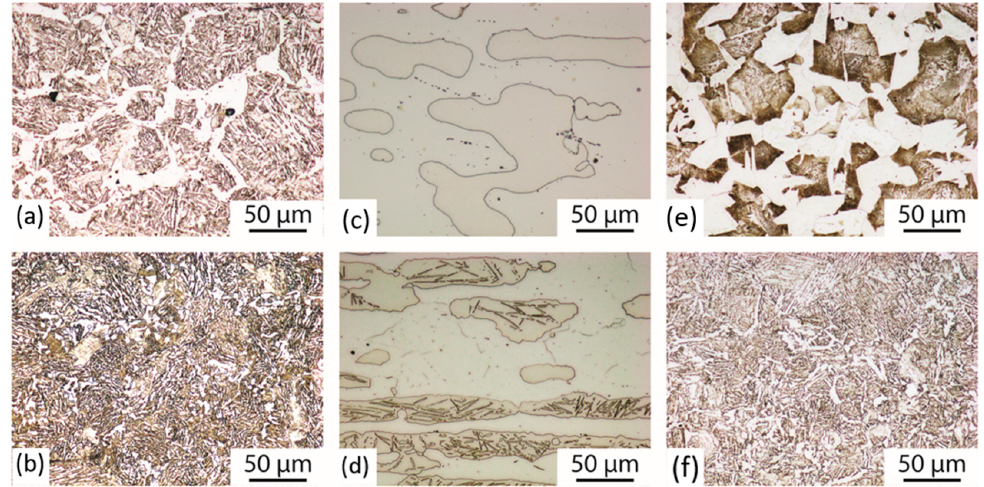
Figure 2. Development of microstructure; upper part—forged and annealed samples, lower part—heat treated samples; ( a , b ) 1.5Al-1.5Mn steel; ( c , d ) 6Al-4Mn steel; ( e , f ) Mn-Si